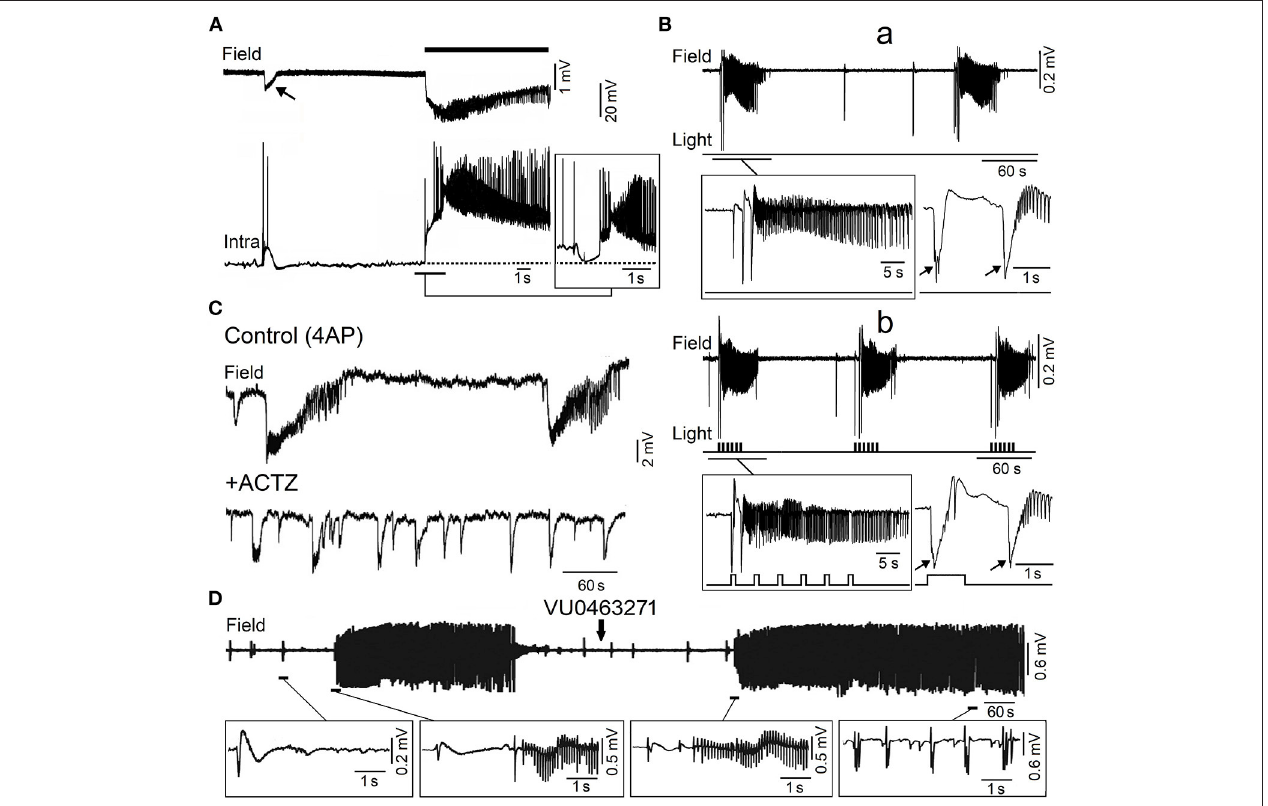
FIGURE 4 | Epileptiform activity induced by 4AP in the adult entorhinal cortex in in vitro brain slices. (A) Simultaneous field (Field) and intracellular (Intra) recordings obtained from adult rat entorhinal cortex in vitro during bath application of 4AP; the recordings shown in the insert were obtained from a different neuron that was depolarized by intracellular current injection to a steady membrane potential at ∼ 62mV. (B) Low voltage fast onset ictal discharges occur spontaneously during bath application of 4AP in the mouse entorhinal cortex (a) but are also triggered by optogenetic stimulation of parvalbumin positive-interneuron (b). The onset of the ictal discharges occurring under each condition is further expanded in the inserts below; note that the ictal discharges are preceded by one or two slow interictal spikes (arrows) under both spontaneous and stimulated conditions. (C) Field potential recordings obtained from the rat entorhinal cortex under control conditions (4AP) and 20min after bath application of carbonic anhydrase inhibitor acetazolamide (ACTZ, 10 µ M); note that this pharmacological procedure greatly reduces the duration of the ictal discharges. (D) Effects of the KCC2 blocker VU0463271 on the 4AP-induced field potential activity recorded from the rat entorhinal cortex; note that addition of VU0463271 induces a pattern of continuous interictal spikes in the field potential recording. Enlarged examples of the field potential recordings are shown below. [ (A) Is modified from Lopantsev and Avoli (1998); (B) is modified from Shiri et al. (2016); (C) is modified from Hamidi and Avoli (2015a); (D) is modified from Chen et al. (2019)